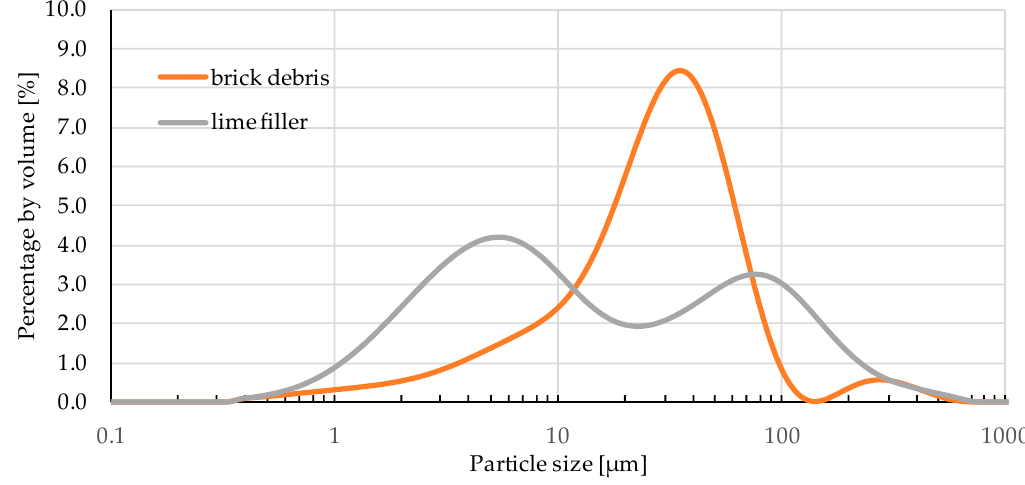
Figure 5. Grading curves of the tested fillers.